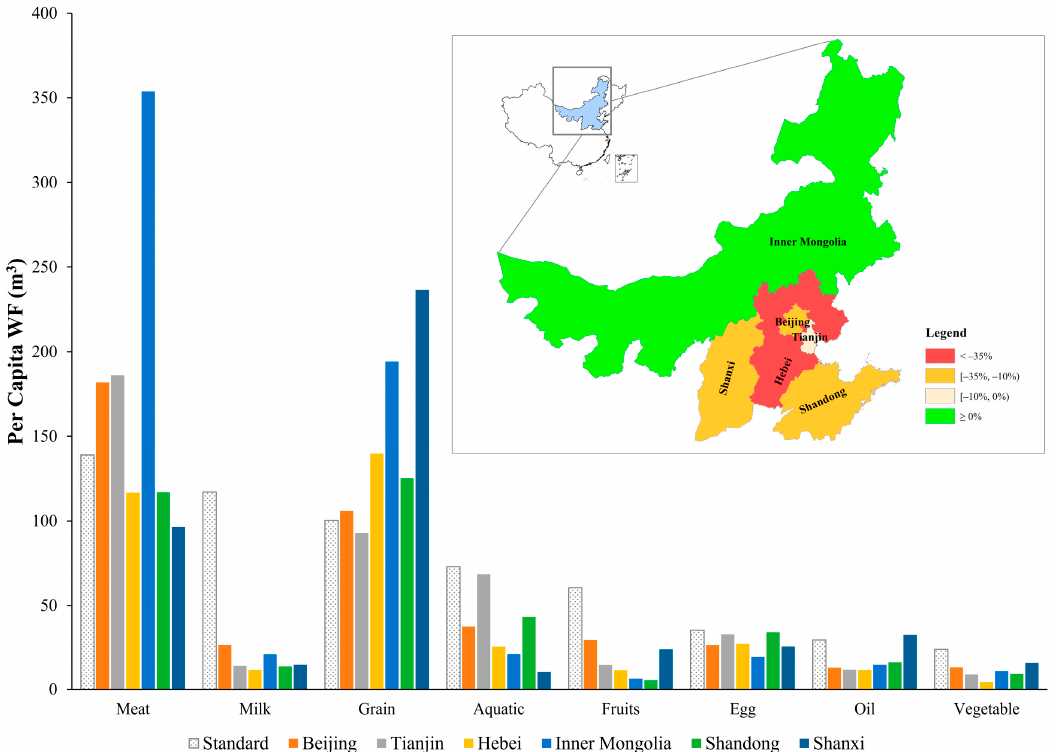
Figure 6. Comparison of actual and standard WF of food consumption by food types in North China. Note: The actual WF is the food consumption WF in 2017; the standard WF is calculated based on the food consumption recommended by the Chinese Dietary Guidelines.